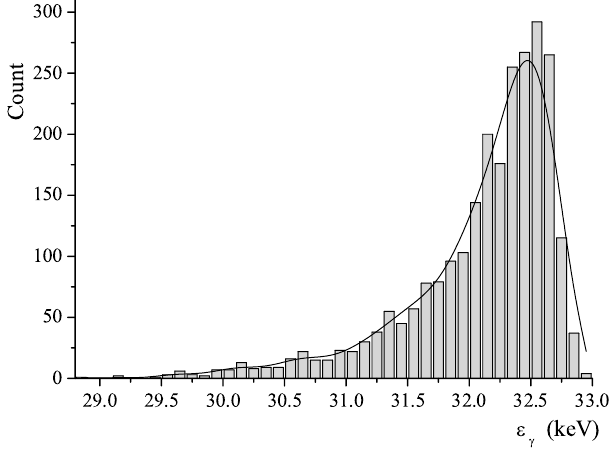
FIG. 9. Spectrum of scattered photons within 1 mrad collima- (cid:1) 43 MeV , collision angle tion angle. Electron beam energy E 0 (cid:1) . (cid:1) 10 (cid:16) 7 m , ’ (cid:1) 150 (cid:12) , steady-state emittances of electron beam . x z (cid:1) 6 : 6 (cid:14) 10 (cid:16) 6 m . 10 (cid:16) 6 m , . s